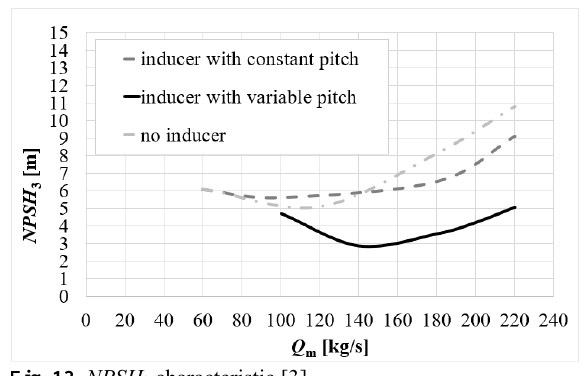
considerably in comparison to the inducer with